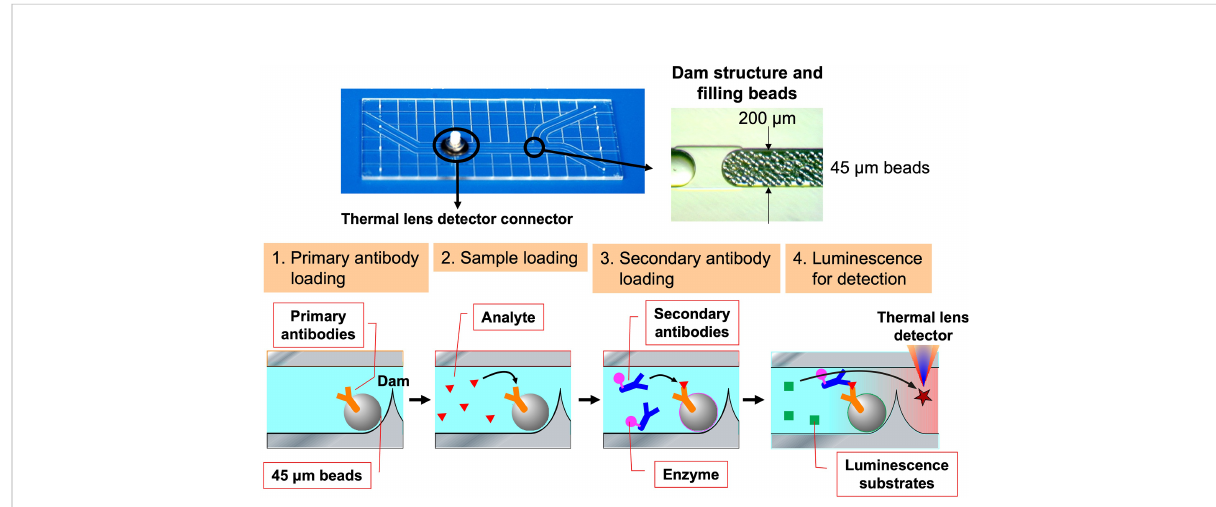
FIGURE 7 The device enables measurement of cytokine levels produced by a single B cell. The ultra-sensitive protein analysis device was developed through a medical-engineering collaboration between the University of Tokyo Graduate School of Engineering and Medicine, which uses a 3 cm × 7 cm glass substrate to create a fl ow channel for bead enzyme-linked immunosorbent assay to measure cytokine levels with 100 to 1,000 times greater sensitivity than conventional methods. Polystyrene beads attached to primary antibodies are fi lled into this device and restrained by a dam formed in the fl ow channel. The analyte in the sample is captured by the primary antibody and subsequently labeled by the second antibody combined with the enzyme. Finally, the enzymatic reaction causes the substrate to emit light, and the signal is detected by thermal lens